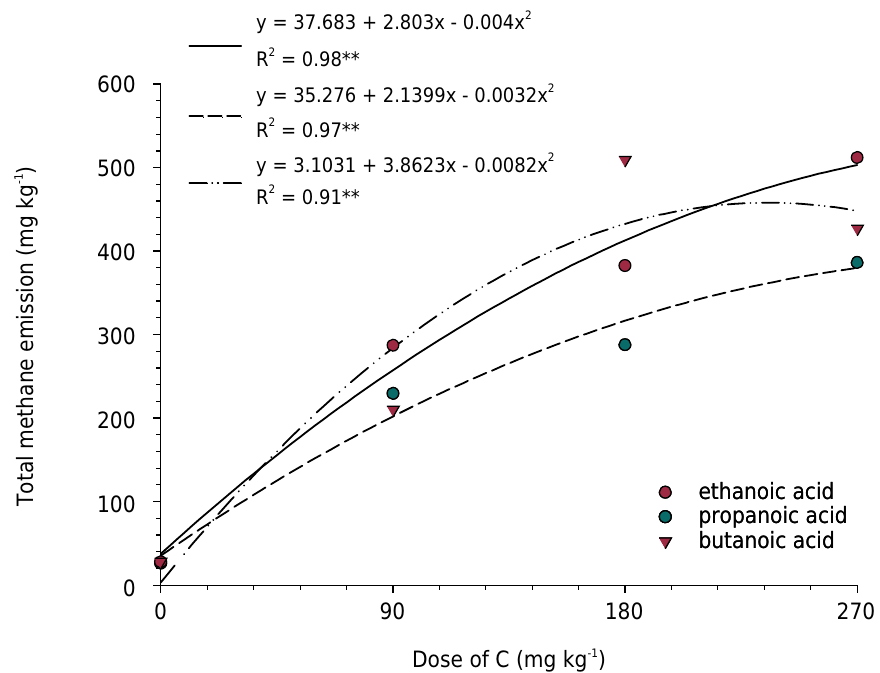
Figure 2. Regression of total CH 4 emission as a function of carbon doses from three short-chain organic acids. ** : significant at 1 % using the F